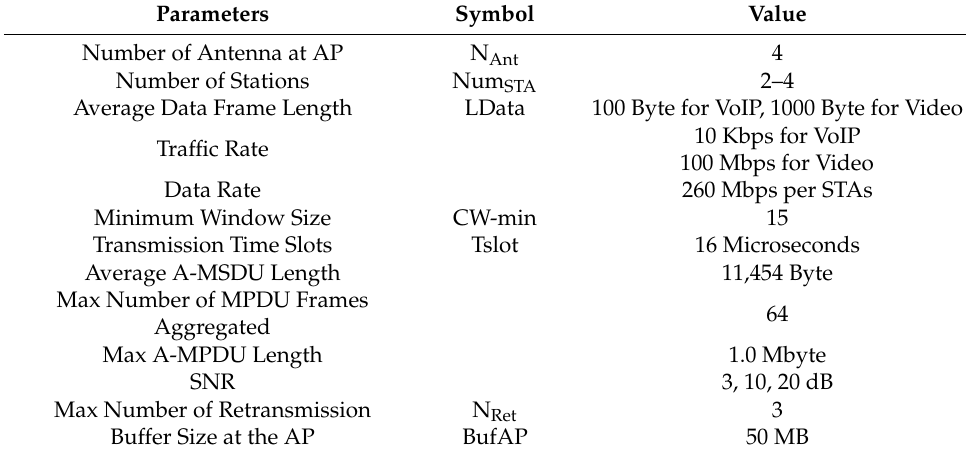
Table 1. Simulation